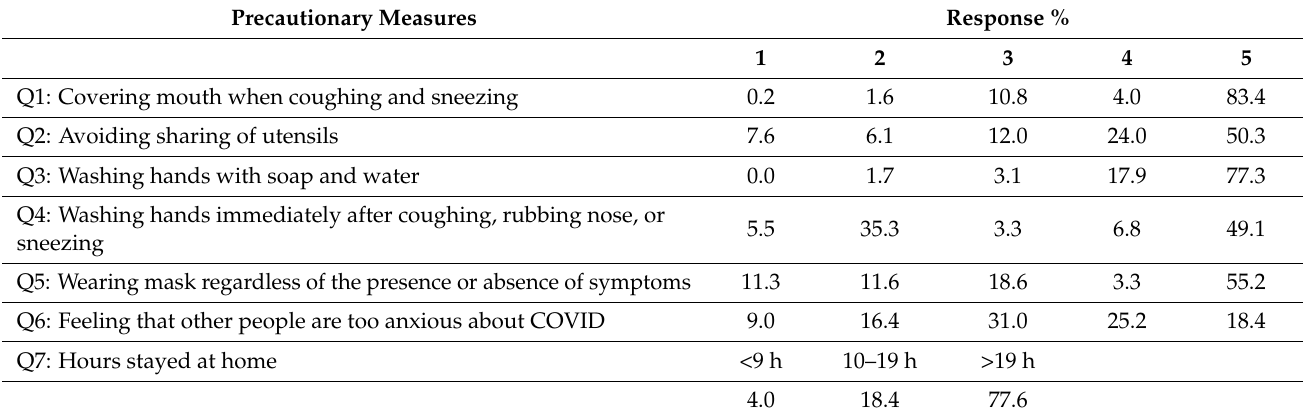
Table 1. Percentage of participants ( n = 1109) following different precautionary measures. Response alternatives: 1 = never; 2 = occasionally; 3 = sometimes; 4 = most of the time; 5 =